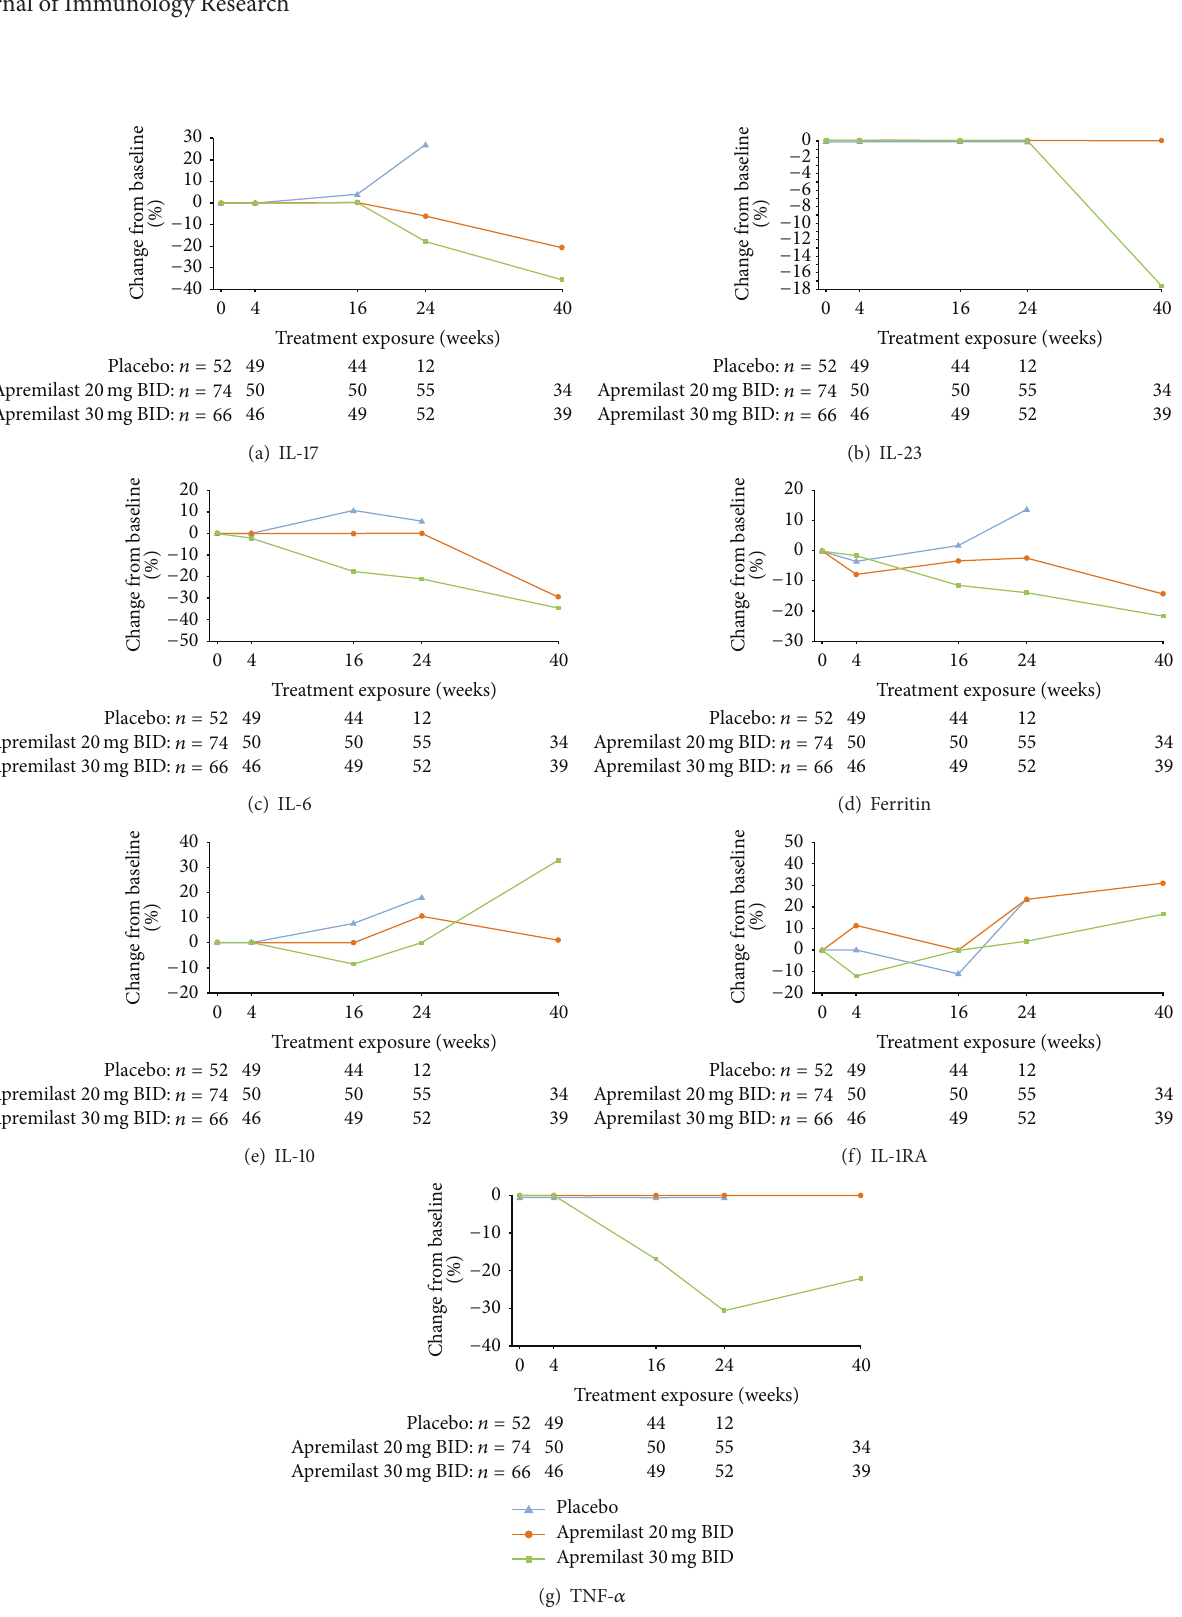
Figure 4: Median percent change in select biomarkers with placebo, apremilast 20mg BID, and apremilast 30 mg BID over Weeks 0 to